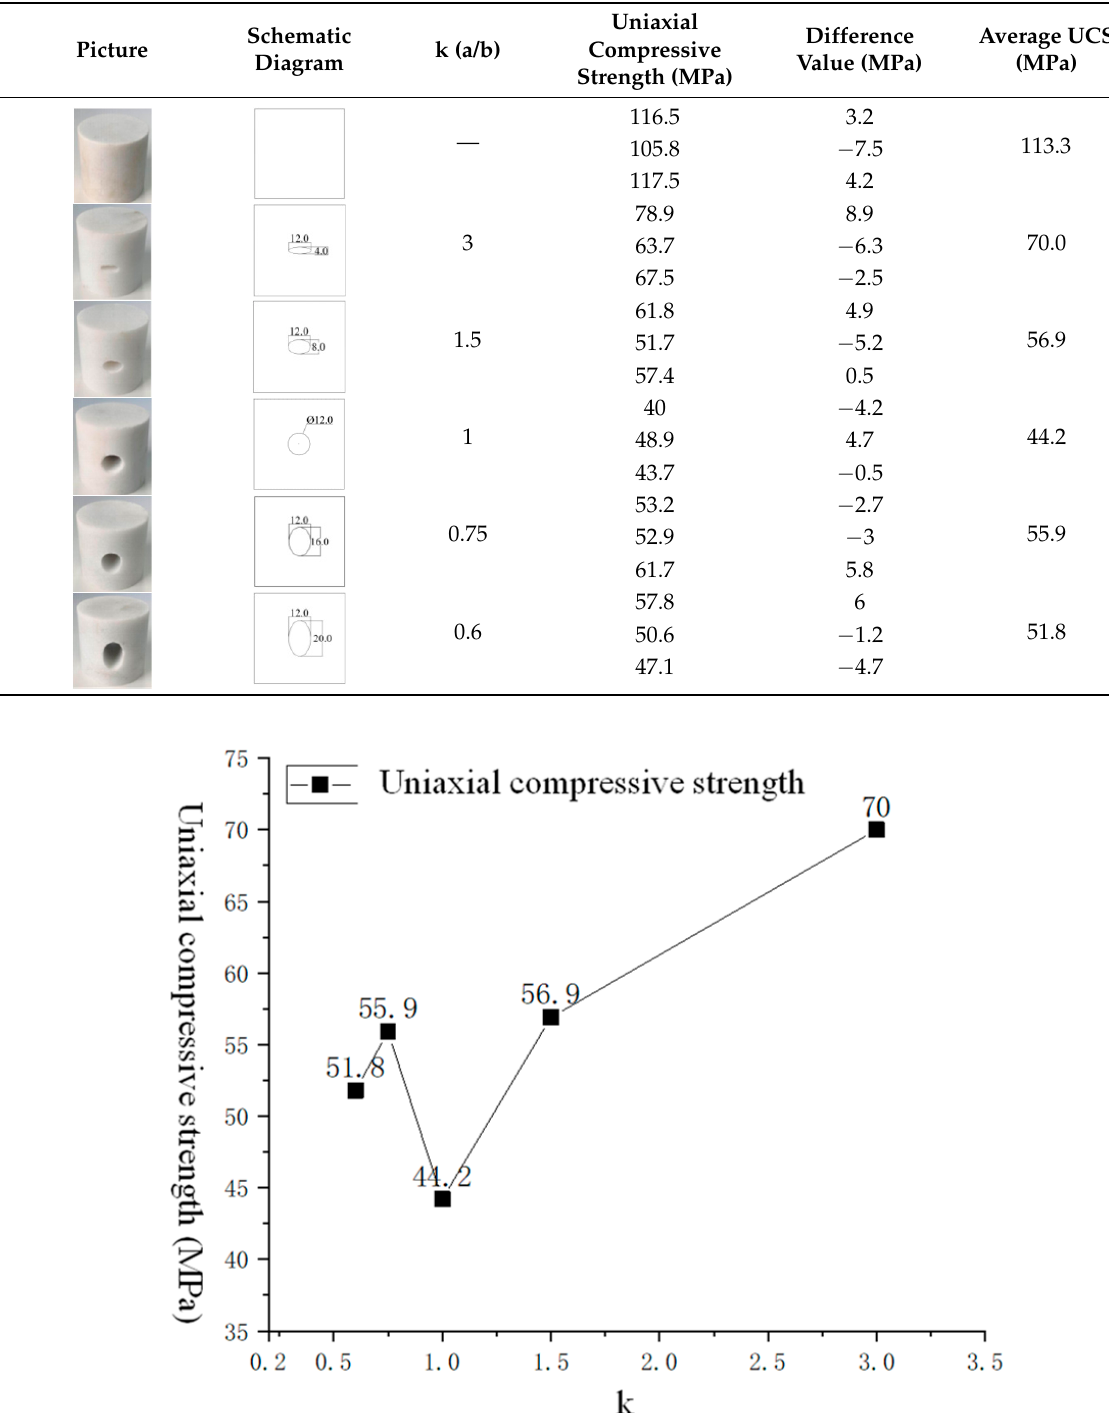
Figure 4. Trend chart of uniaxial compressive strength changing with k. Table 1. Uniaxial compressive strength of all samples.